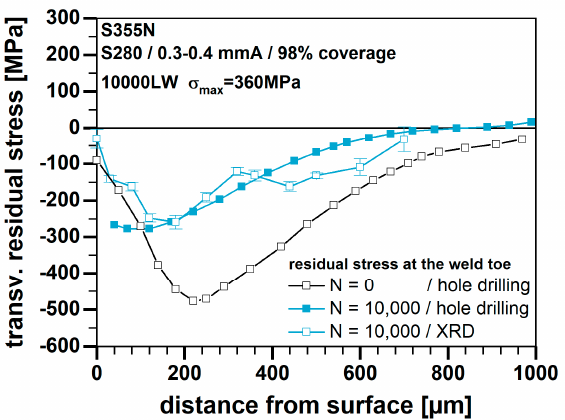
Figure 6. Change of residual stress depth profiles in shot peened (steel shots, intensity 0.3–0.4mmA, coverage of 98%) DV-butt welds under cyclic loading. Cyclic loading at R = 0.1 with maximum stress of 360 MPa.